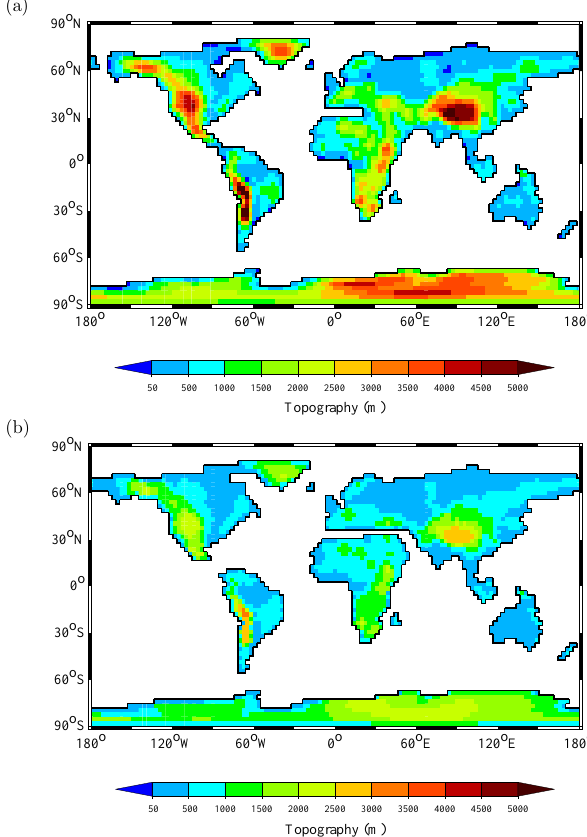
Fig. 2. Oceanic surface heat transfer for (a) the CTRL configuration and (b) the Miocene configuration. Positive values indicate a net transfer of heat from the ocean to the atmosphere.